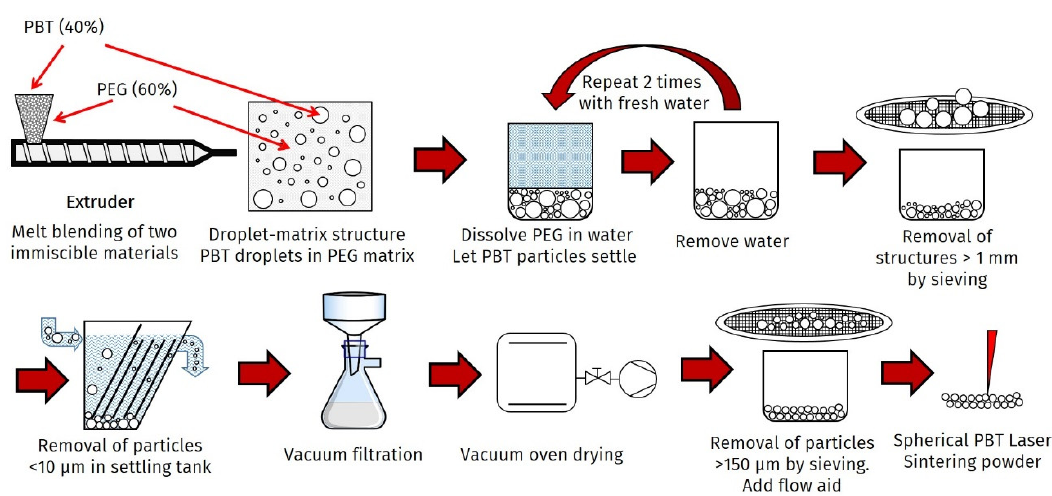
Figure 2. Schematic overview of the powder production process. PBT: polybutylene terephthalate.